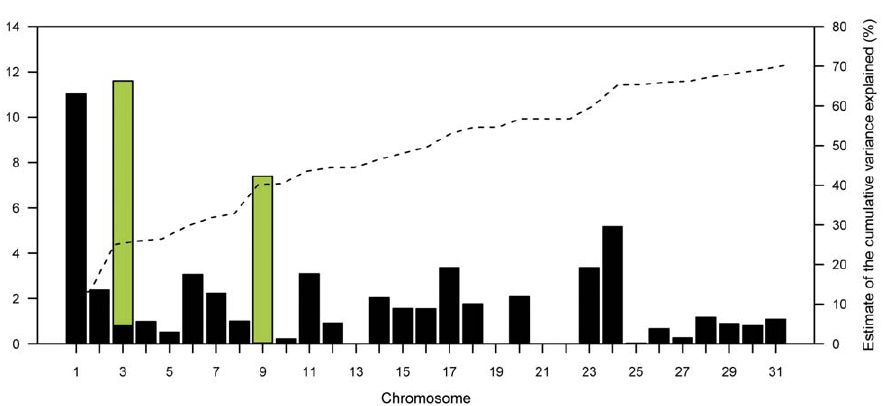
Figure 4. Estimates of height at withers dEBV variance explained by SNPs on 31 autosomes (black bars) and the two identified QTL (green bars). The two QTL combined explain 18.2% of the variance. All chromosomes together explain 70.2% of the genetic